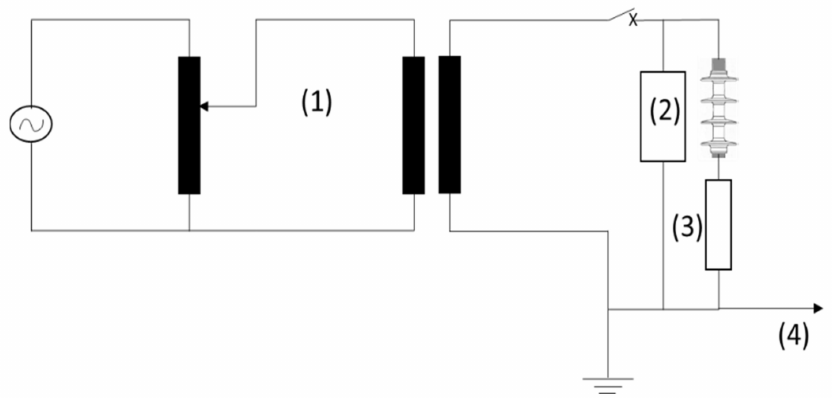
Figure 2. Diagram of the test circuit. ( 1 ) Voltage supply conductor, ( 2 ) Test insulator, ( 3 ) Shunt resistor, and ( 4 ) to DAQ